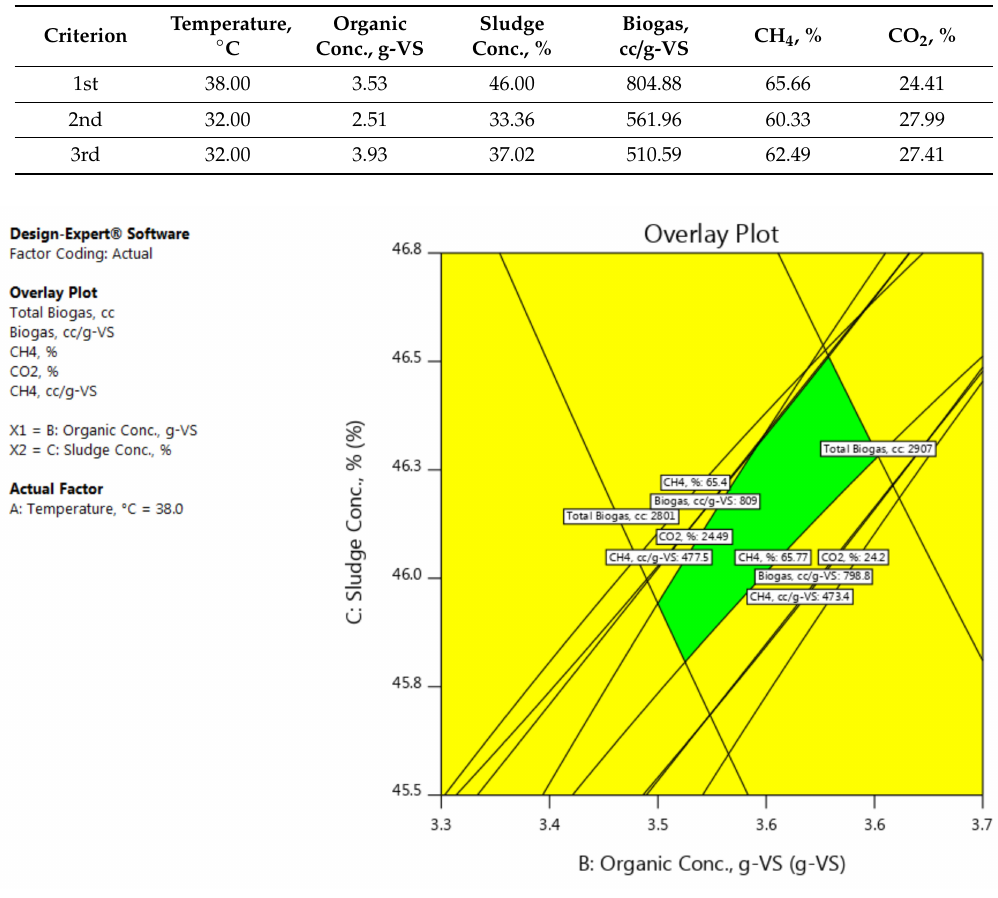
Figure 11. An overlay plot illustrating the optimum biogas based on the quality